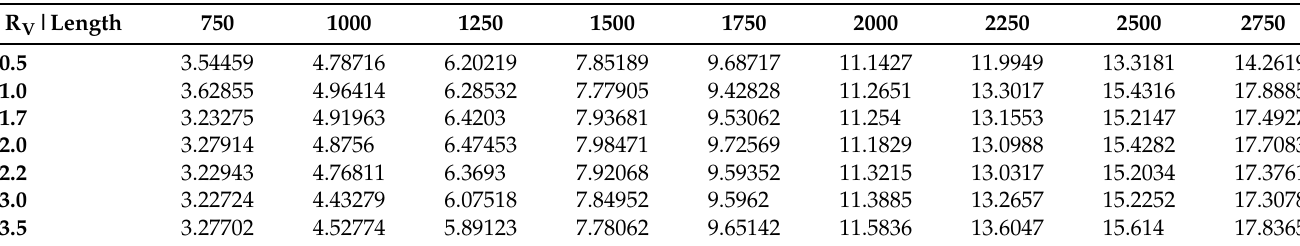
Table A10. Execution times in milliseconds on CPU with ring structure for 30,000 time-steps (1.5 s); R V on the Left and number of cells (length) on the Top .